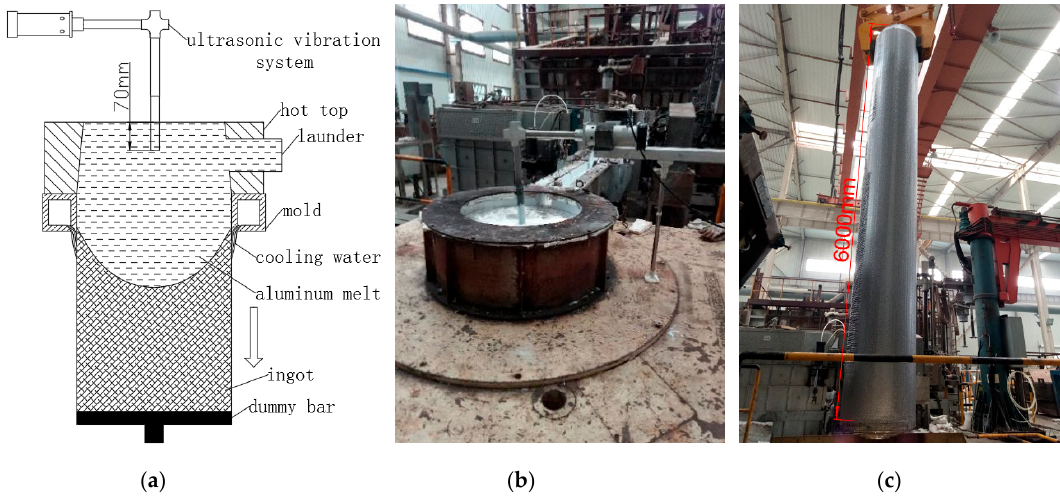
Table 2. Casting process parameters of the 2A14 aluminum ingots.